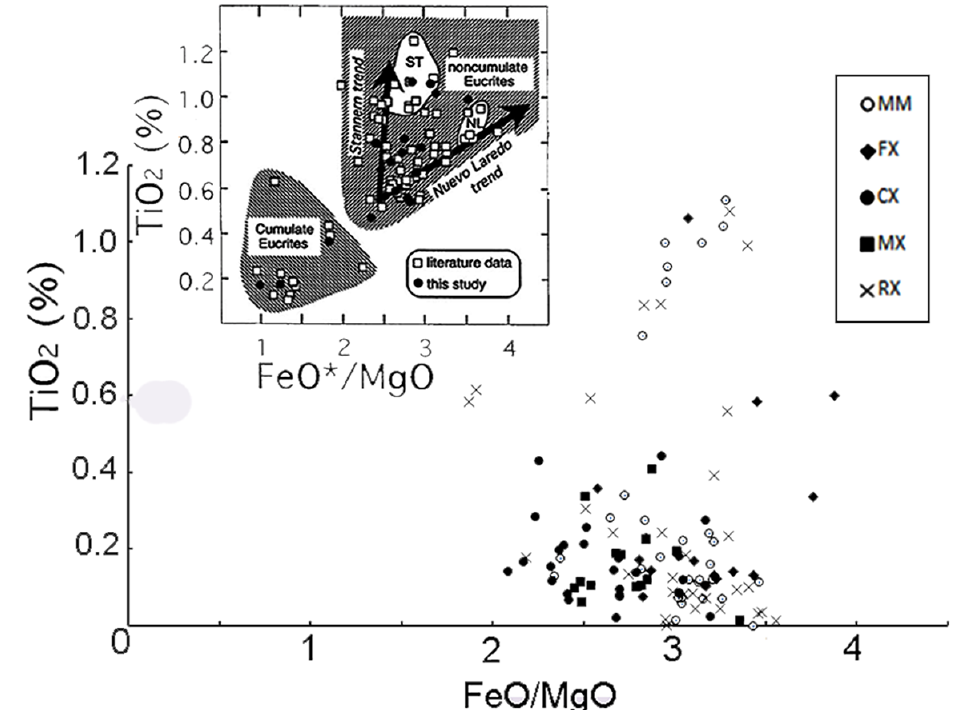
for Serra Pelada eucrite, showing different ratios for each clast and Figure 8 - Plot of FeO/MgO vs. TiO 2 matrix. This plot is compared with literature data taken from Barrat et al. (2000), the small figure inside the